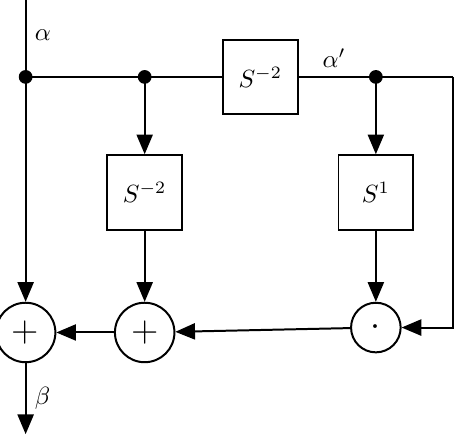
Figure 6: Non-linear Layer of Dasta